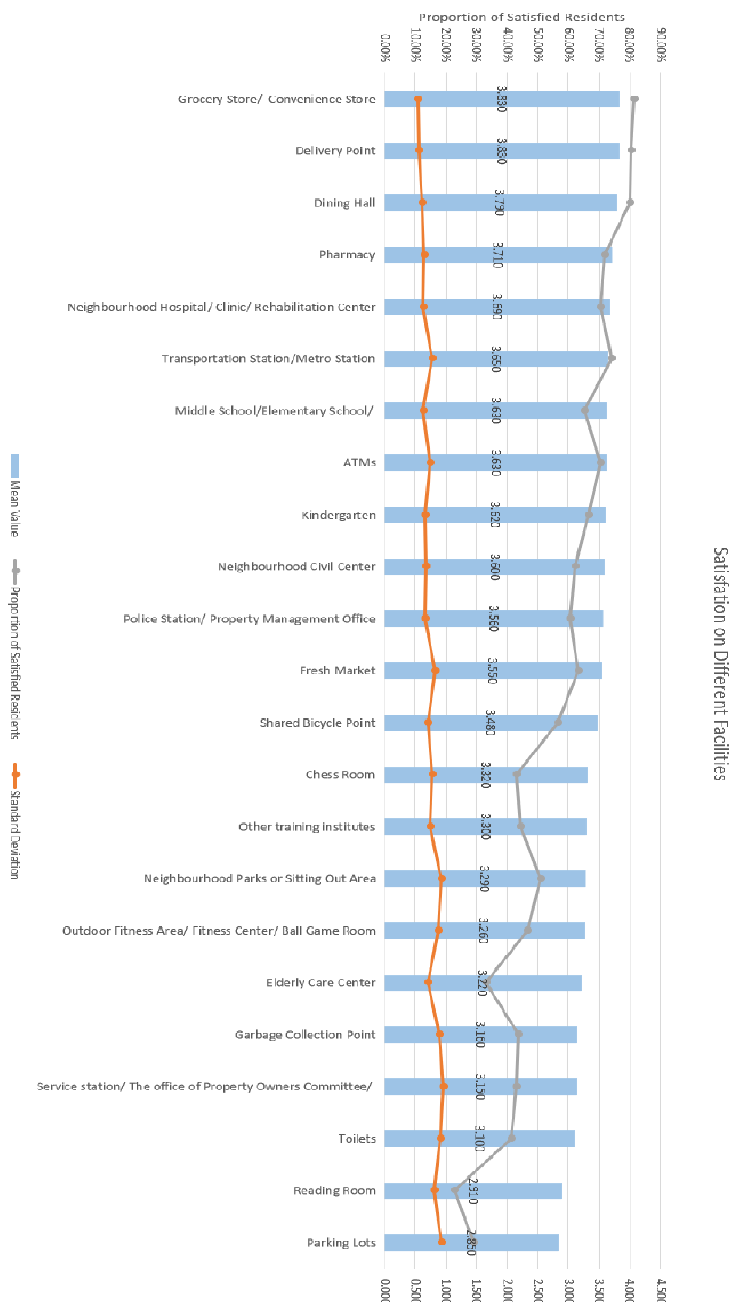
Figure 5. The mean values and variations in residential satisfaction for various amenities and proportion of satisfied respondents.